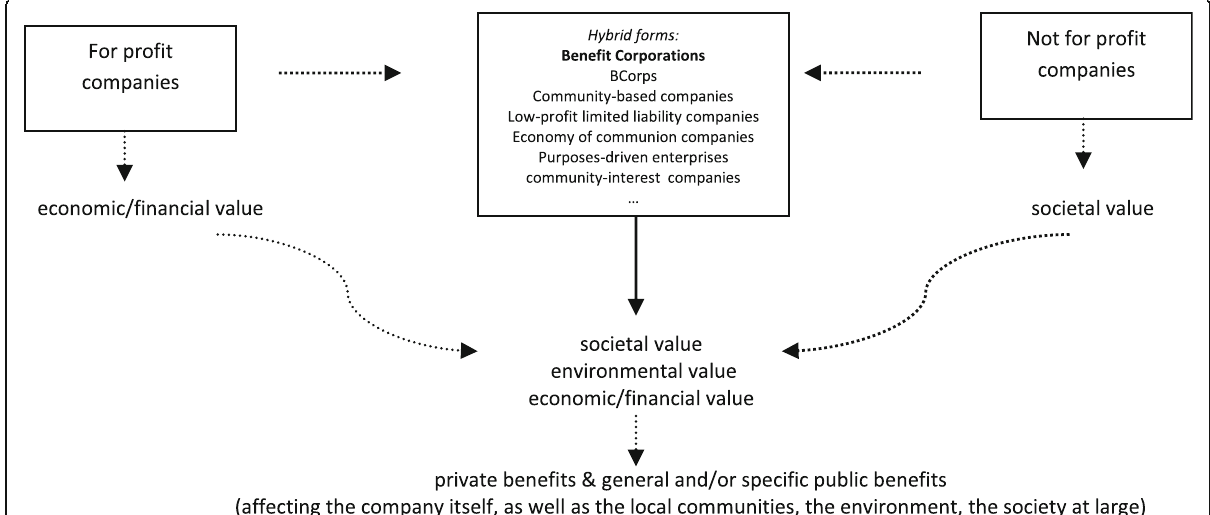
Fig. 1 The dynamic balance between economic and societal